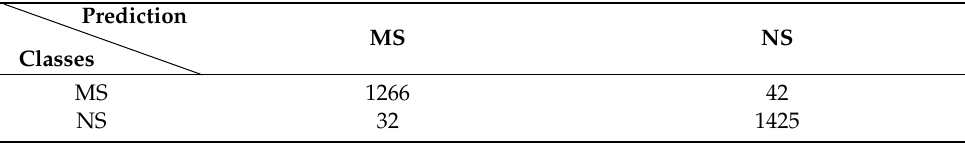
Table 4. Confusion matrix of the validation dataset. MS and NS represent the microfracture signal and noise signal,